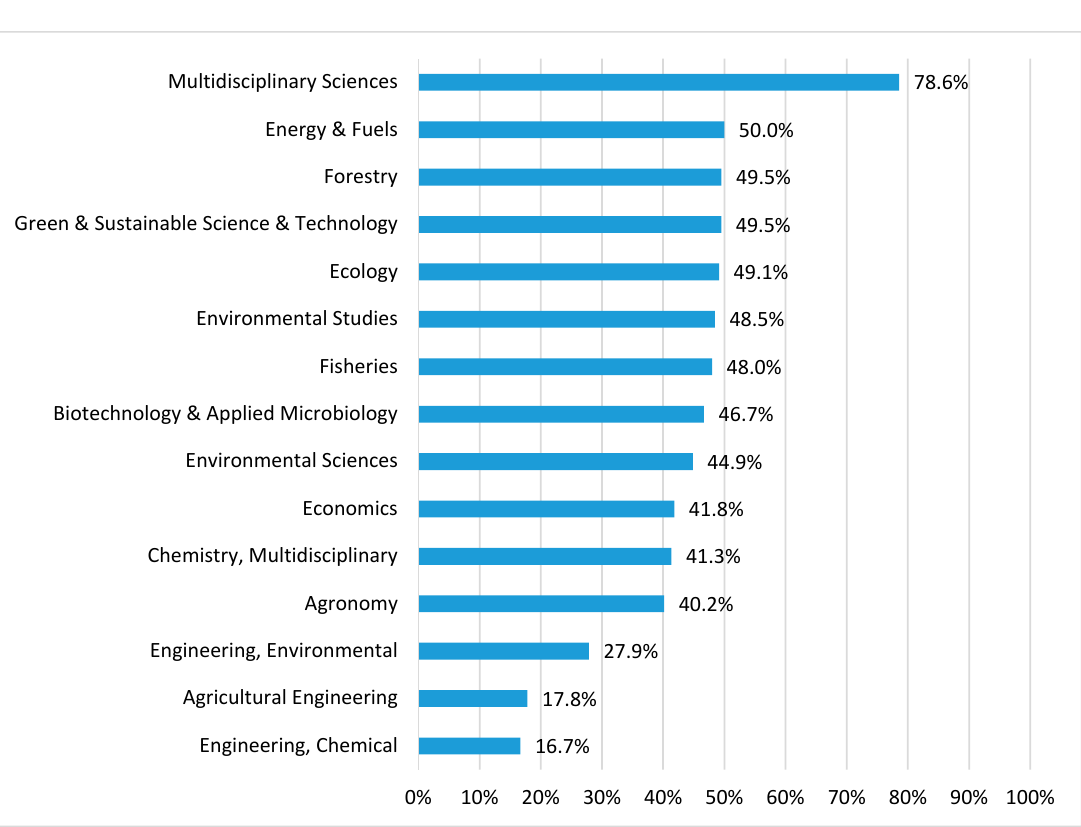
Figure 9. Share of OA articles in the 15 most important research areas ( n = 1135).